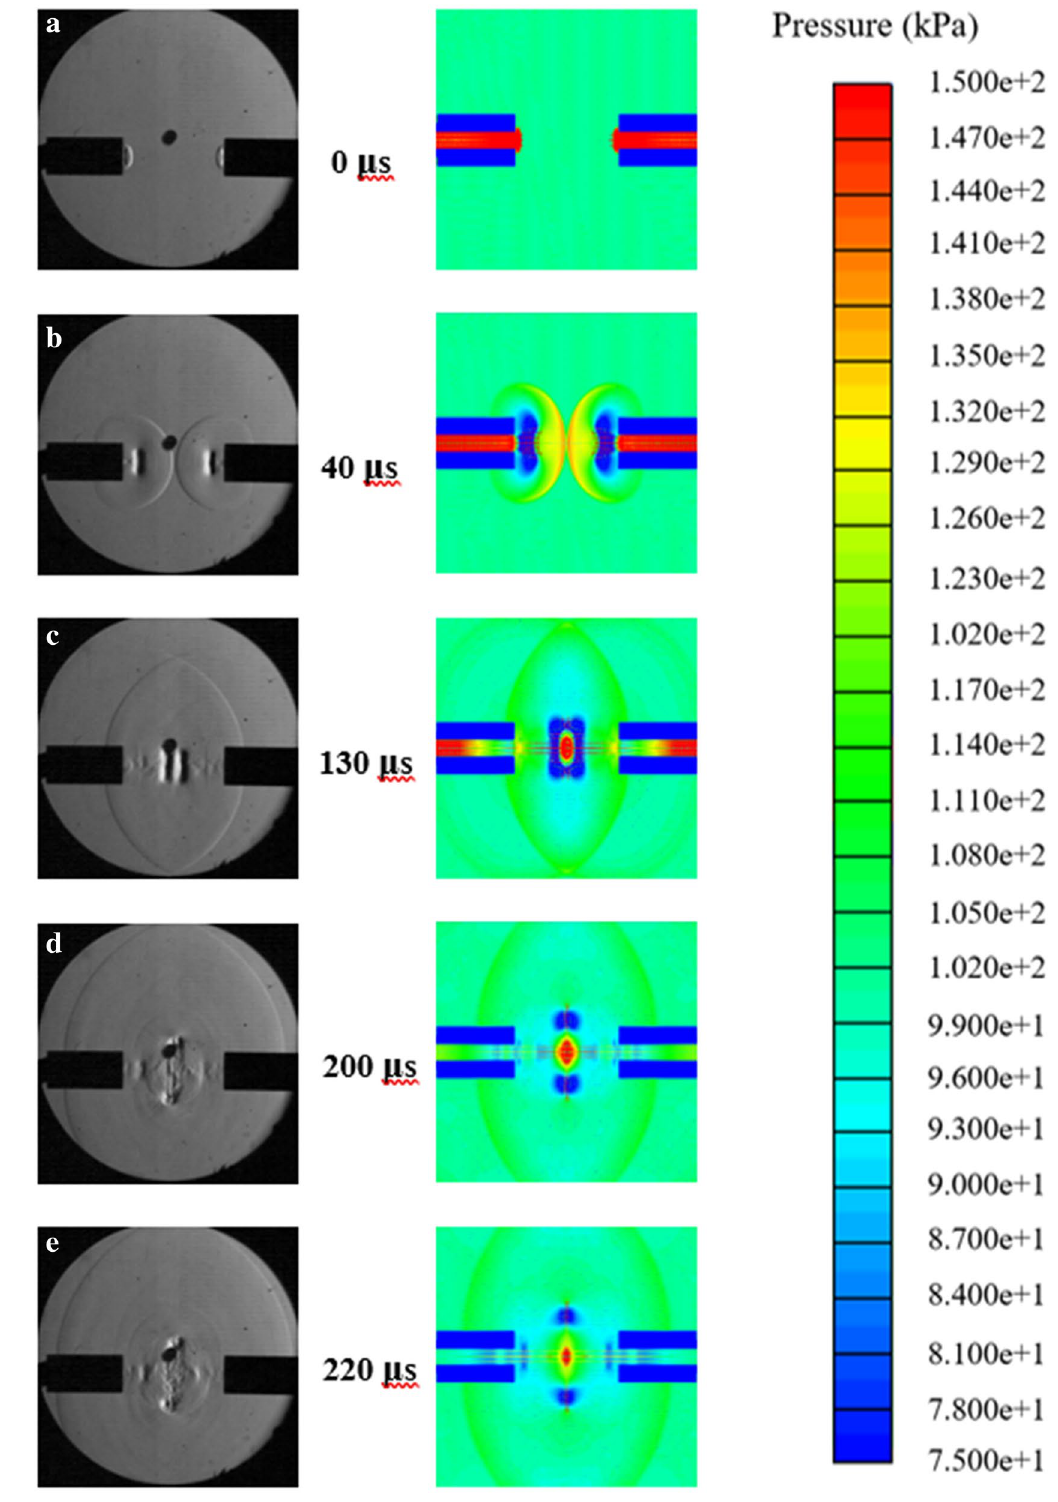
Figure 1. ( a ) The shock waves exiting the tube ( b ) The vortex rings exiting the tube ( c ) The collision of the vortex rings ( d ) The resulting shock wave from the collision of vortex rings e: Turbulent flow moving away from the